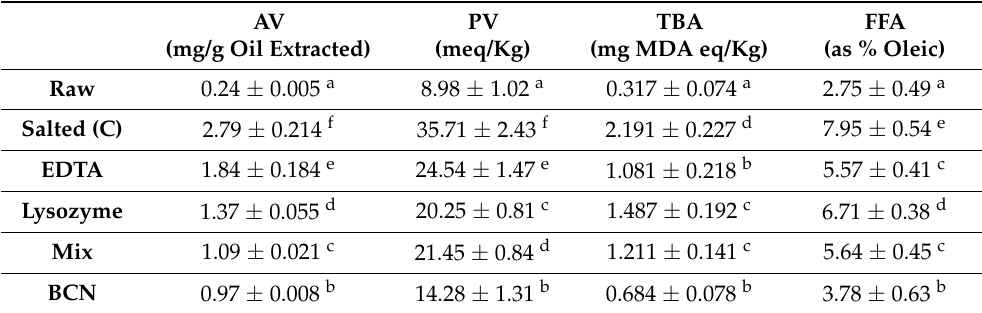
Table 2. The changes in lipid profile of the treated salted mullet samples compared to the commercial